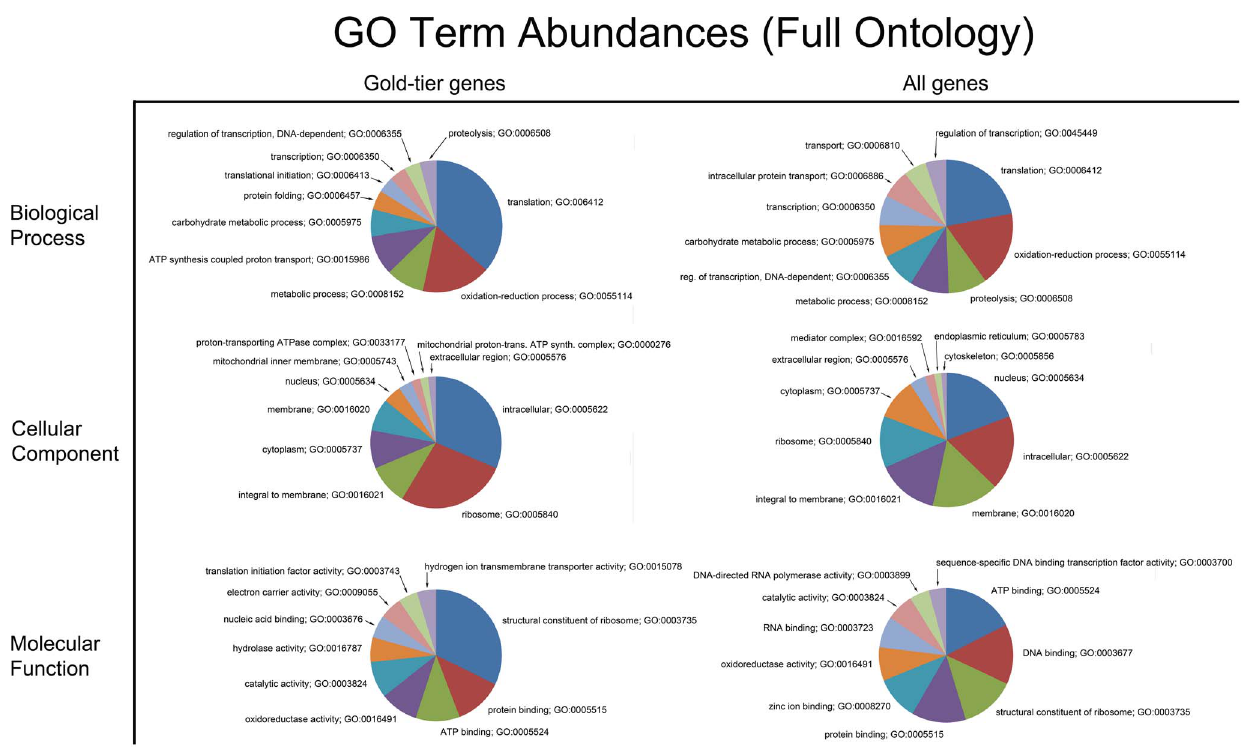
Figure 1. GO term abundances (full ontology). Shown are pie charts presenting the relative abundance of the ten most frequently encountered gene ontology (GO) terms for both the 838 gold-tier PUT subset, as well as the complete 49,613 PUT set. GO terms contribute additional annotation information for inferred gypsy moth genes along three dimensions: biological process, cellular component and molecular function. The GO terms recovered were stratified according to these ontology domains.